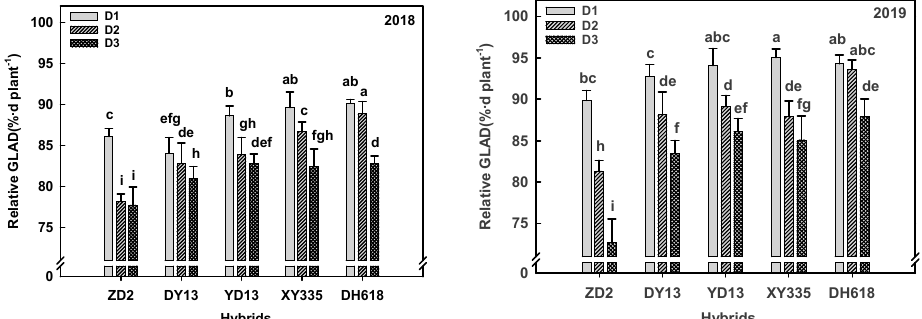
Figure 3. Changes in relative GLAD under different densities in 2018 and 2019. Different letters on the graph indicate significant differences at p < 0.05.